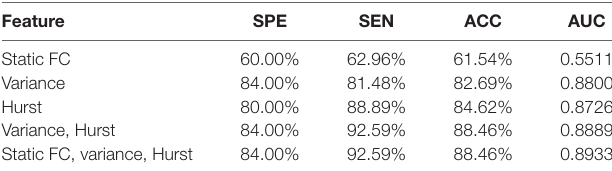
TABLE 2 | Classification performances of different types of features.